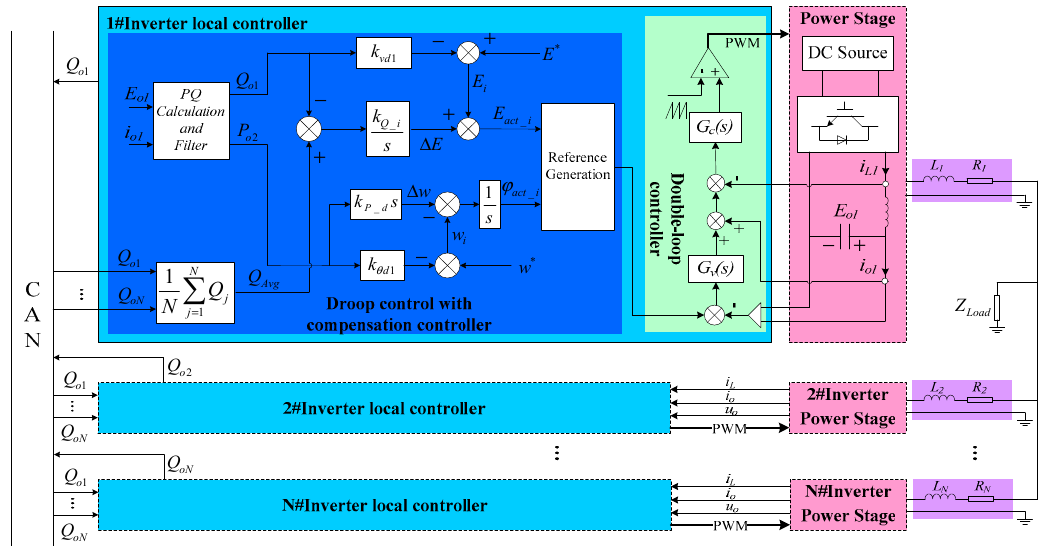
Figure 3. Control configuration diagram of inverter parallel system with proposed droop control method.